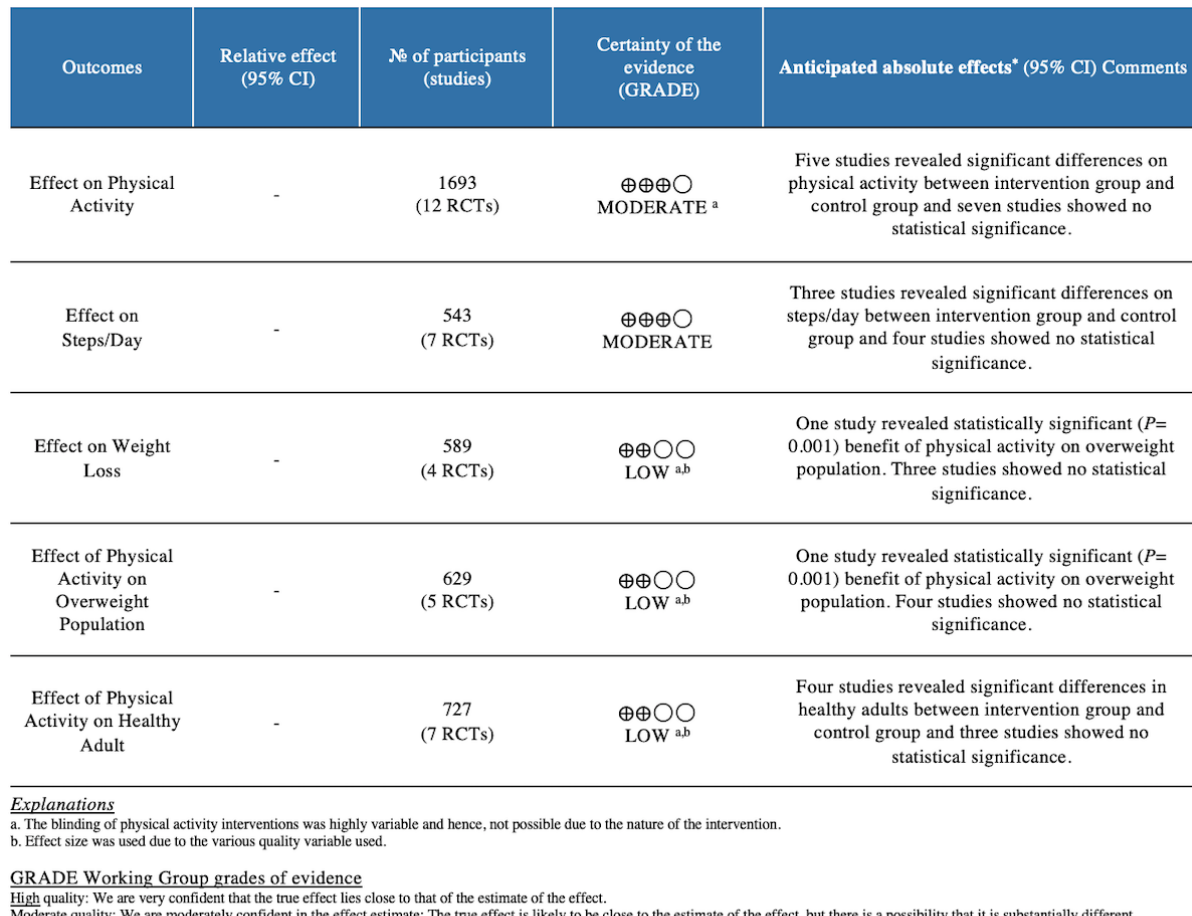
Figure 7. GRADE Working Group grades of evidence